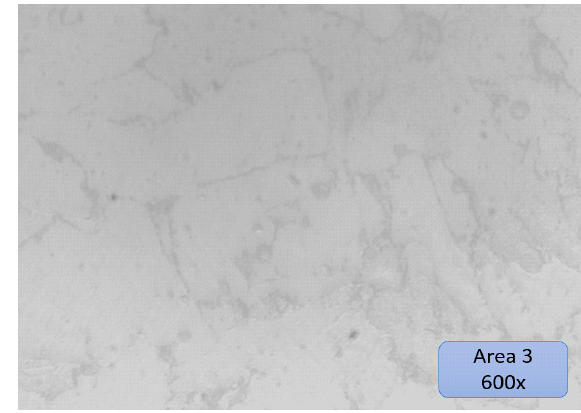
Figure 25. Substrate material area 2, with dilution, substrate, and their overlapped transition area marked in rectangles.